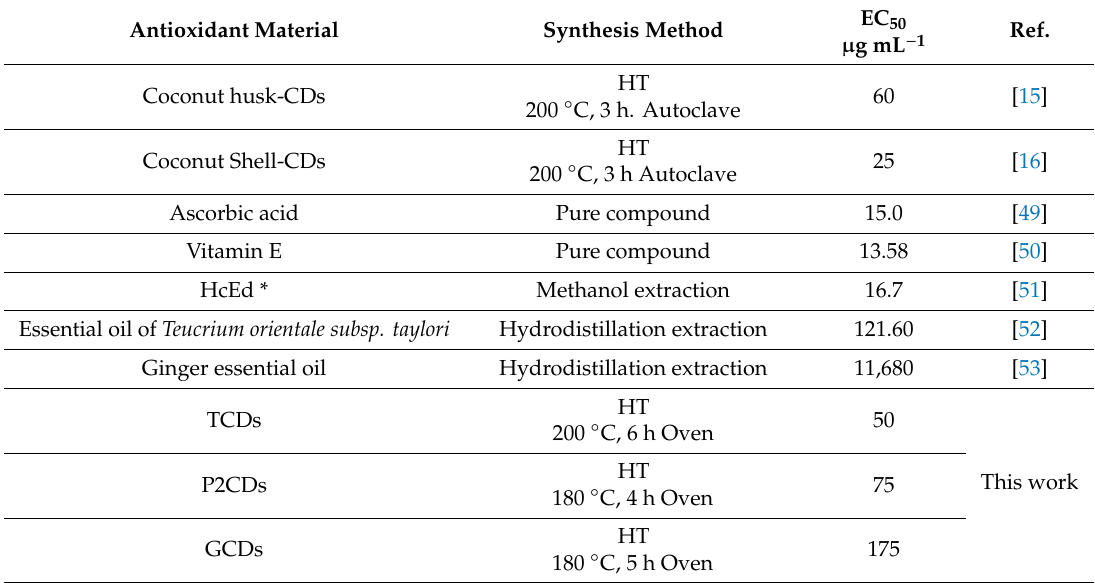
Table 3. Comparison of EC 50 values (DPPH assay) for the CDs studied with those of some reported